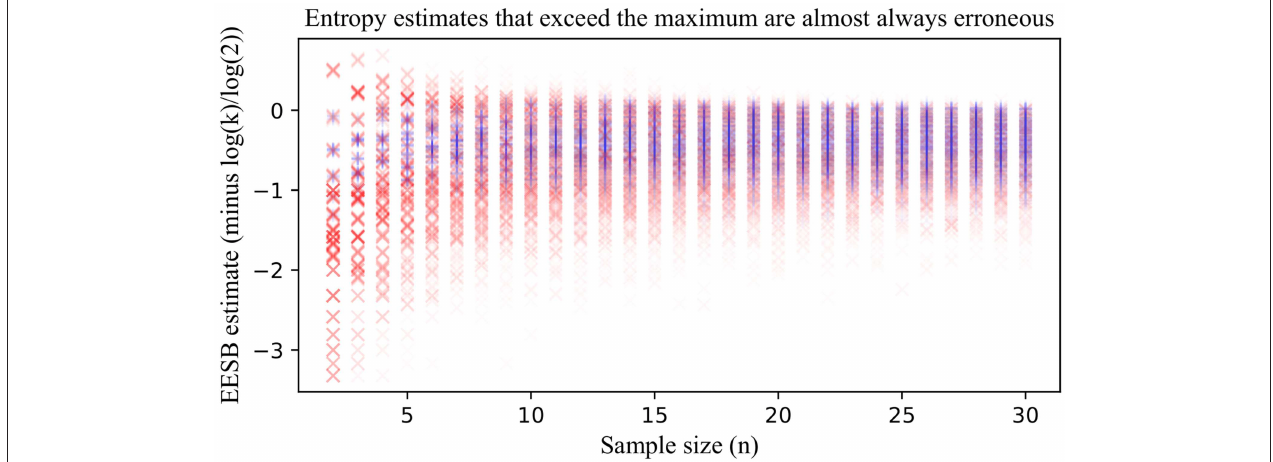
FIGURE 2 | From the simulated data experiment, the EESB estimated entropy minus the maximum entropy for the number of categories in that distribution is plotted against the sample size. All values > 0 would be rejected following the recommendation proposed here to reject samples when the EESB entropy is > log 2 k . Blue plusses are used to represent samples where the EESB estimate was within 10% of the actual entropy of the source distribution, while a red x is used to represent samples > 10% of the actual entropy. Samples from low-entropy populations, namely those that are diverse with only a few common types, remain below the maximum entropy even when the sample size is too low to produce accurate estimates, and thus further criteria will be required in the future to distinguish representative and non-representative samples. High-entropy populations, namely those that are diverse, and have approximately equally common types, produce erroneously high estimates when under-sampled, making it easy to distinguish them from more representative samples.